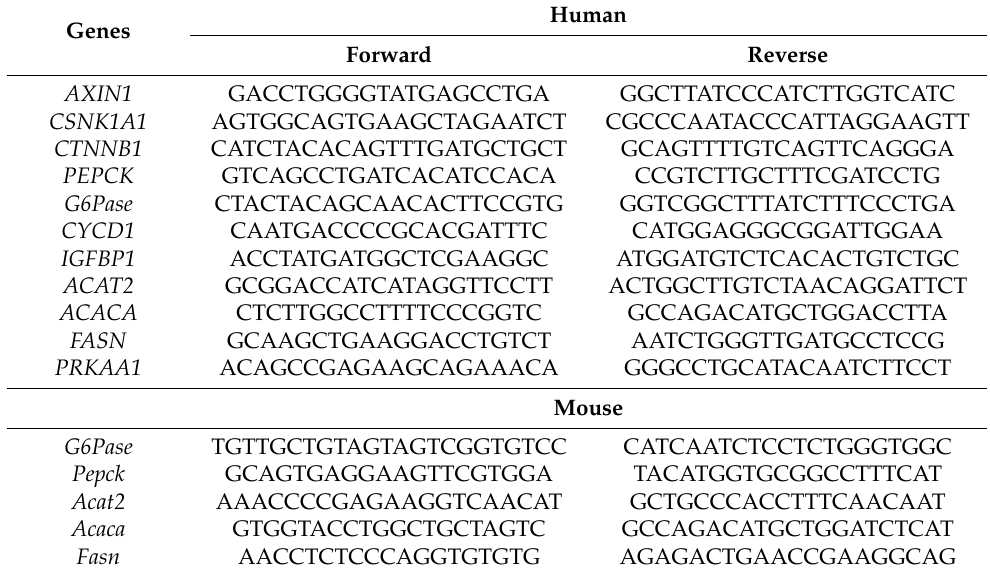
Table 1. Primers used for quantitative